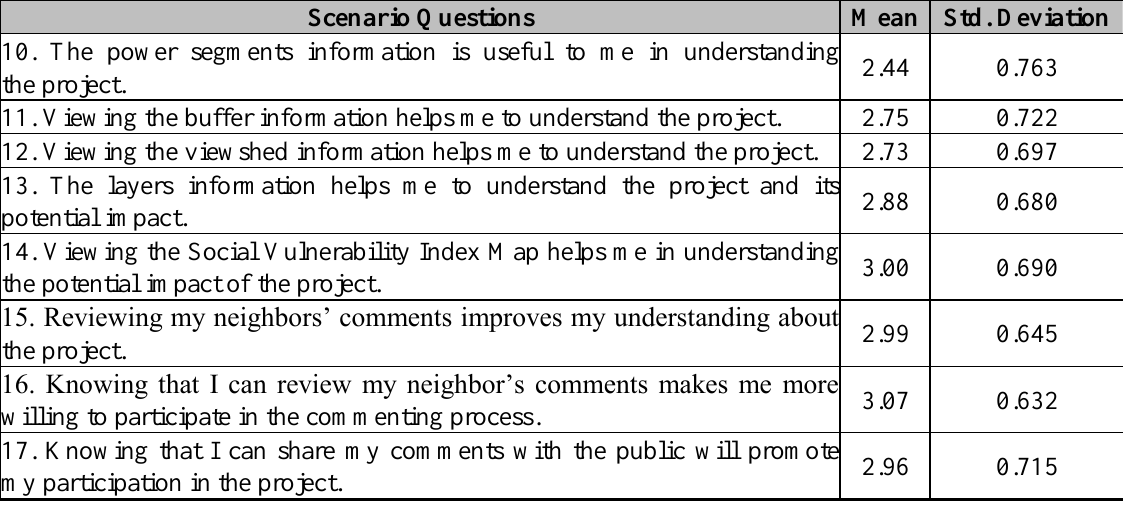
Table 1. Descriptive statistics for the scenario